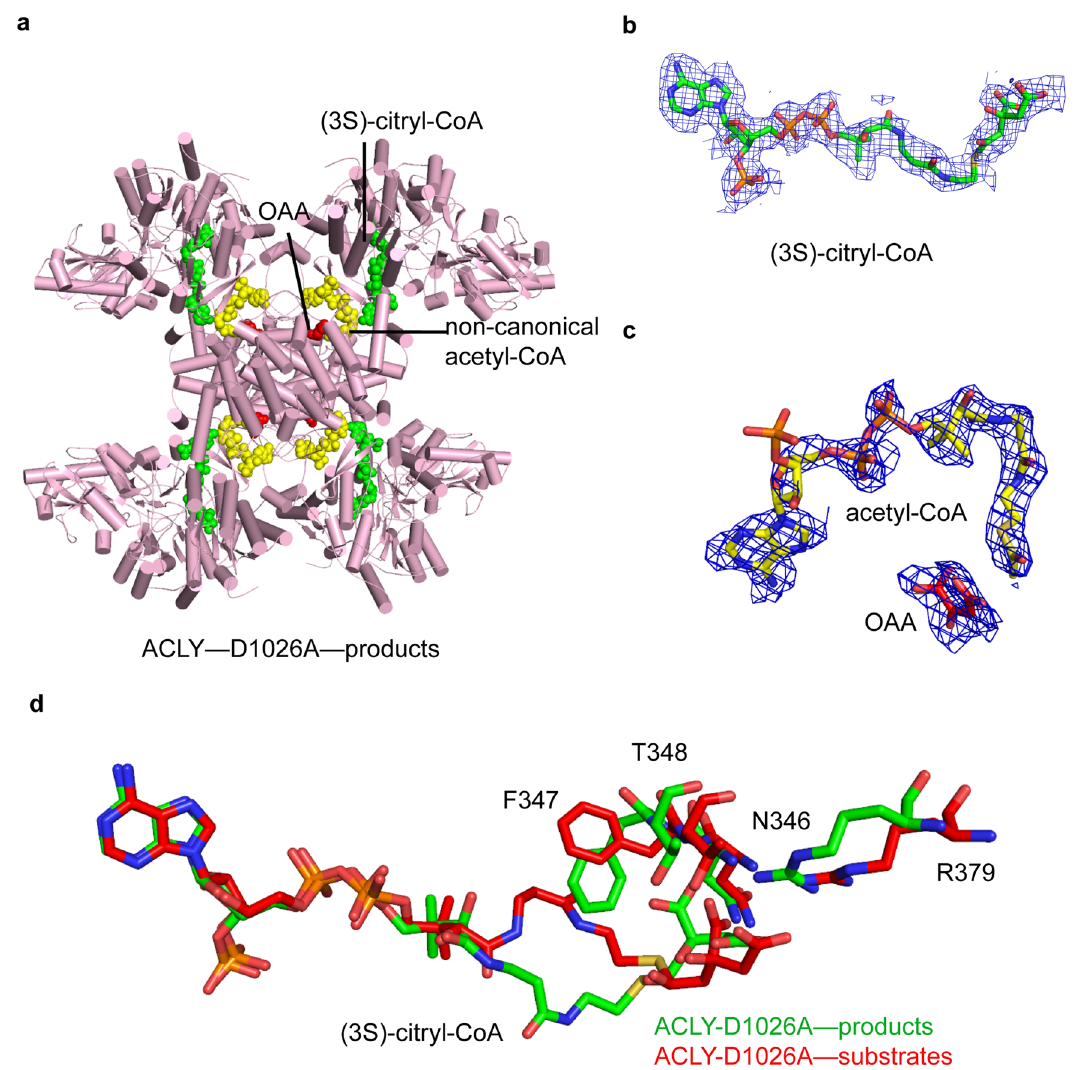
Fig. 4 | Structure ACLY-D1026A with products. a Cartoon presentation of ACLY- D1026A — products structure highlighting bound (3S)-citryl-CoA (green), non- canonicalacetyl-CoA(yellow),andOAA(red)molecules. b Cryo-EMdensityof(3S)-